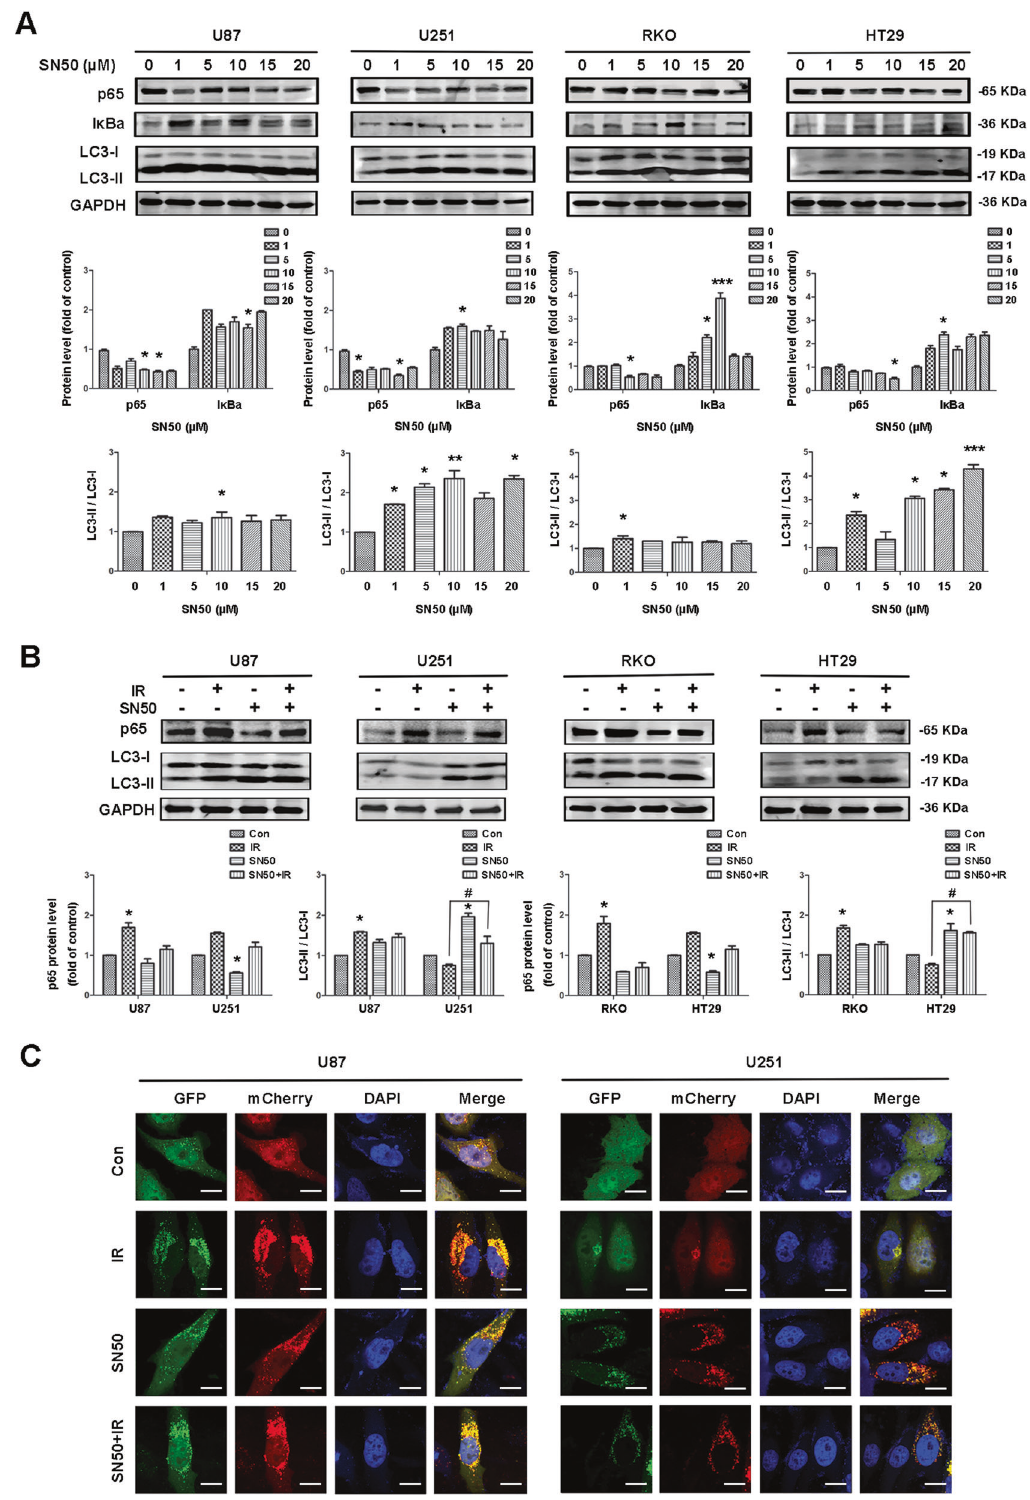
Fig. 4 Evidence for NF- κ B as a negative regulator of autophagy in mut-p53 cells after IR. A Western blotting was used to analyze the changes of p65, I κ Ba, and LC3 proteins after treatment with SN50 at different concentrations in U87, U251, RKO, and HT29 cells. B Western blotting was used to analyze the changes of p65 and LC3 proteins with SN50 pretreatment before IR in U87, U251, RKO, and HT29 cells. C U87 and U251 cells were transfected with GFP-mCherry-LC3 plasmid, then treated as required in each group; fi nally images were taken by confocal immuno fl uorescence (×630) ( * P < 0.05, ** P < 0.01, *** P < 0.001 vs. control; # P < 0.05 compared to the IR group).